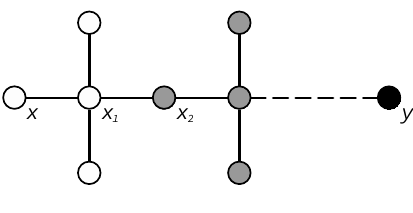
Fig. 6: Diagram showing part of R , which may have an additional colored leaf (not shown). Light gray represents vertices that may not